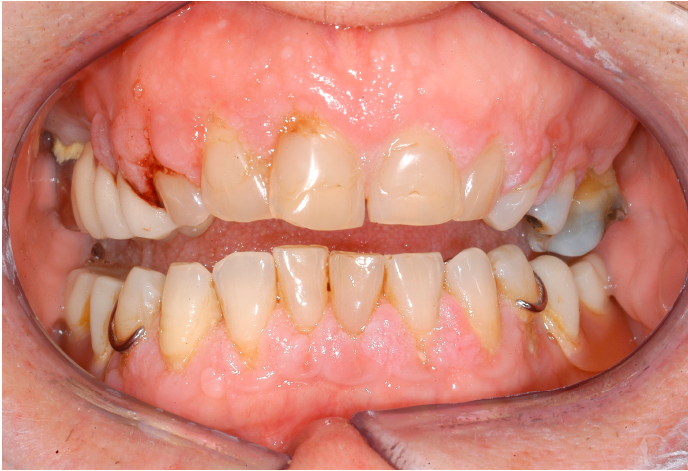
Figure 4. Gingival enlargement as a first sign of Granulomatosis with Polyangiitis in a 72-year-old women.